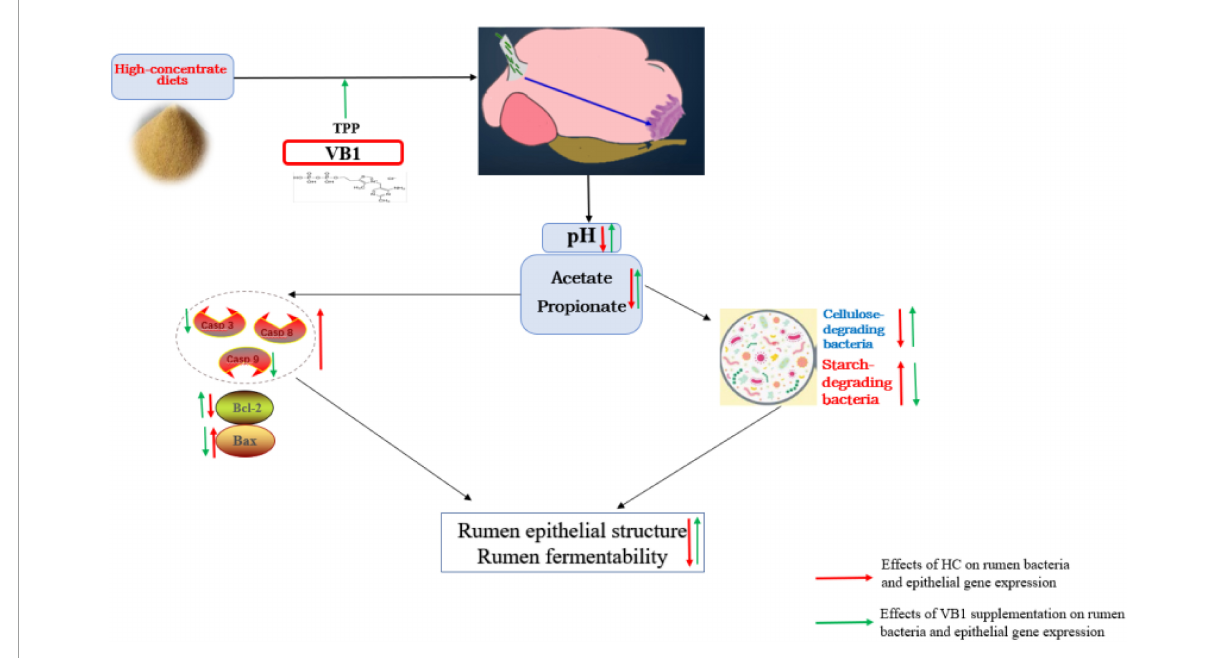
FIGURE5 Potential attenuation mechanism scheme of Vitamin B1 on high-concentrate diets inducing rumen